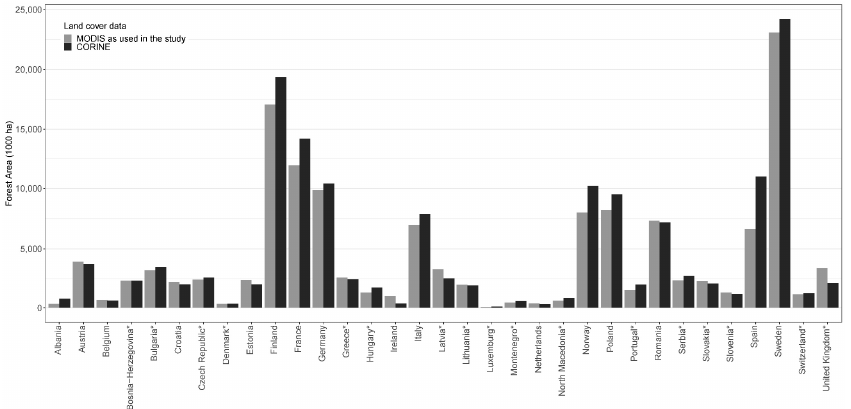
Figure A1. Comparison of the forest area estimations based on MODIS [44] and CORINE [58] land cover data sets. MODIS refers to the forest area mask as used in this study (see Section 2.5) while CORINE refers to a forest area mask based on CORINE land cover data which was not used in the study (see Appendix A). Countries where no inventory data were available are marked with an asterisk. Remote Sens. 2022 , 14 , 395